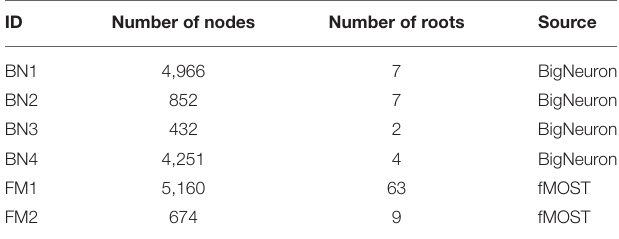
TABLE 2 | Summary of neuron reconstructions from six image